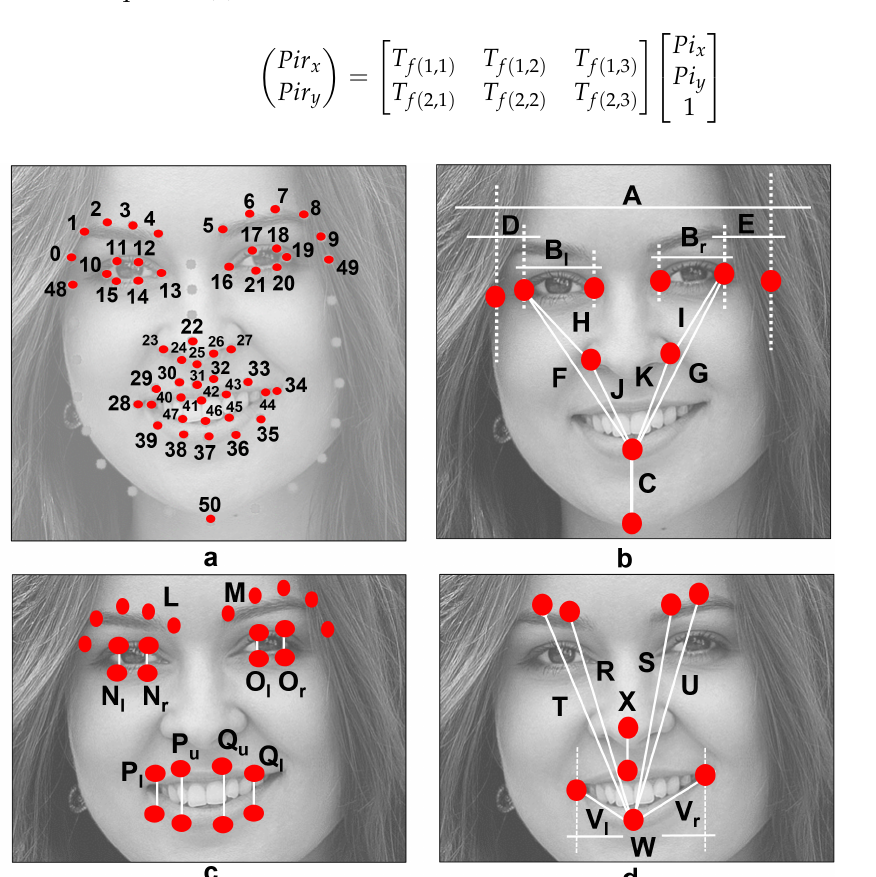
Figure 3. ( a ) The 51 key points inspired in the 68-point model proposed by Matthews and Baker [23]. ( b – d ) Facial distances to compute spatial relations between facial landmarks